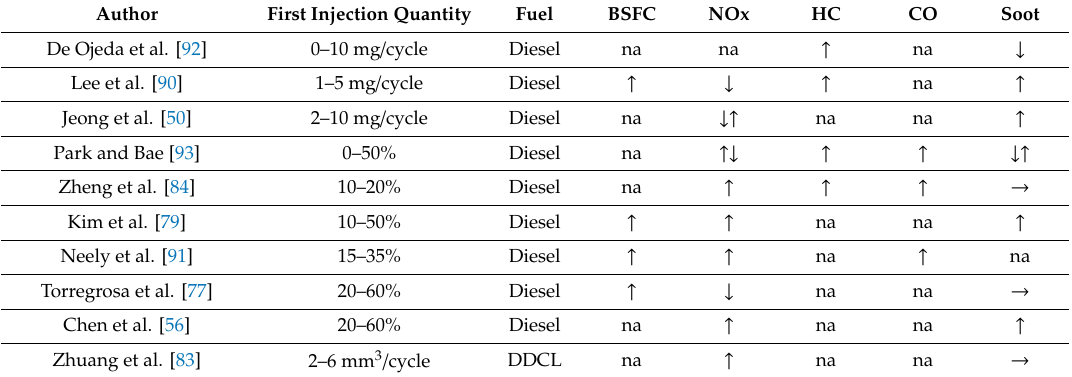
Table 6. Variation of performance and emissions after increasing the first injection quantity